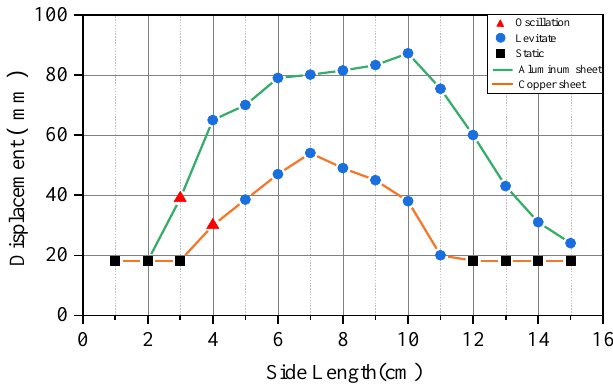
Figure 4. Movement and position of aluminum and copper sheets under different sizes.